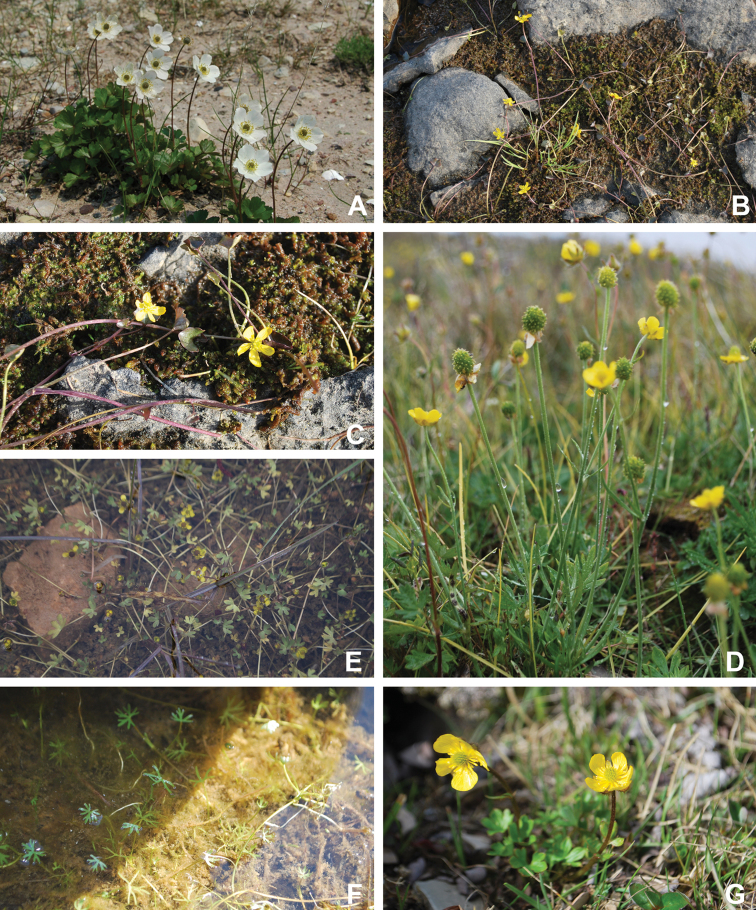
AAnemone
parviflora habit Gillespie et al. 9644BCaltha
palustris
subsp.
radicans habit CCaltha
palustris
subsp.
radicans inflorescences DRanunculus
arcticus habit ERanunculus
hyperboreus
subsp.
hyperboreus habit FRanunculus
gmelinii
subsp.
gmelinii habit GRanunculus
nivalis habit. Photos A by R.D. Bull and B–G by B.A. Bennett.